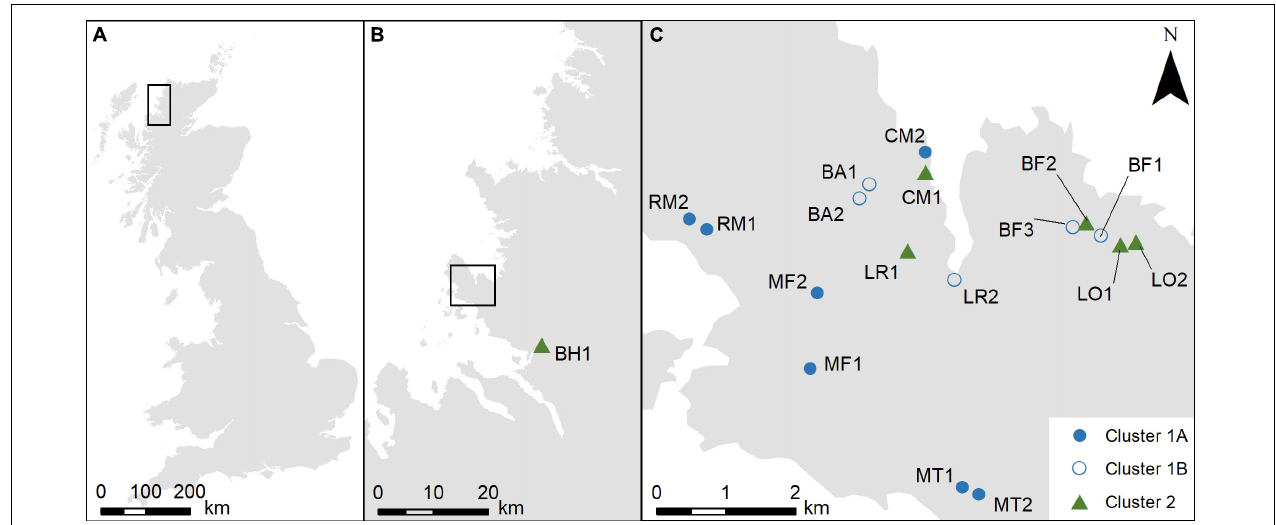
FIGURE 1 | (A) Location of the field area within Britain; (B) location of the Coigach peninsula and the sampling site at Blughasary (BH); (C) distribution of sampling sites on the Coigach peninsula. BA = Brae of Achnahaird; BF = Bad Fhluich; CM = Cnoc Mòr; MF = Meall an Fheadain; MT = Mòine Tomach; LO = Loch Osgaig; LR = Loch Raa; RM = Rubha